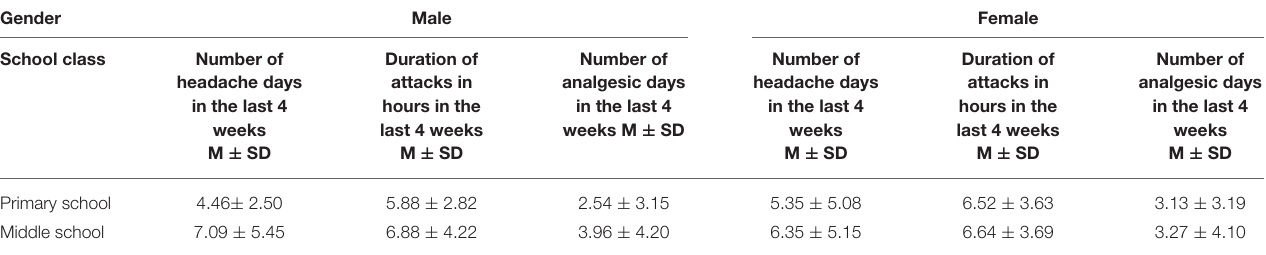
TABLE 3 | Character of Primary headache disorders stratified by school stage and